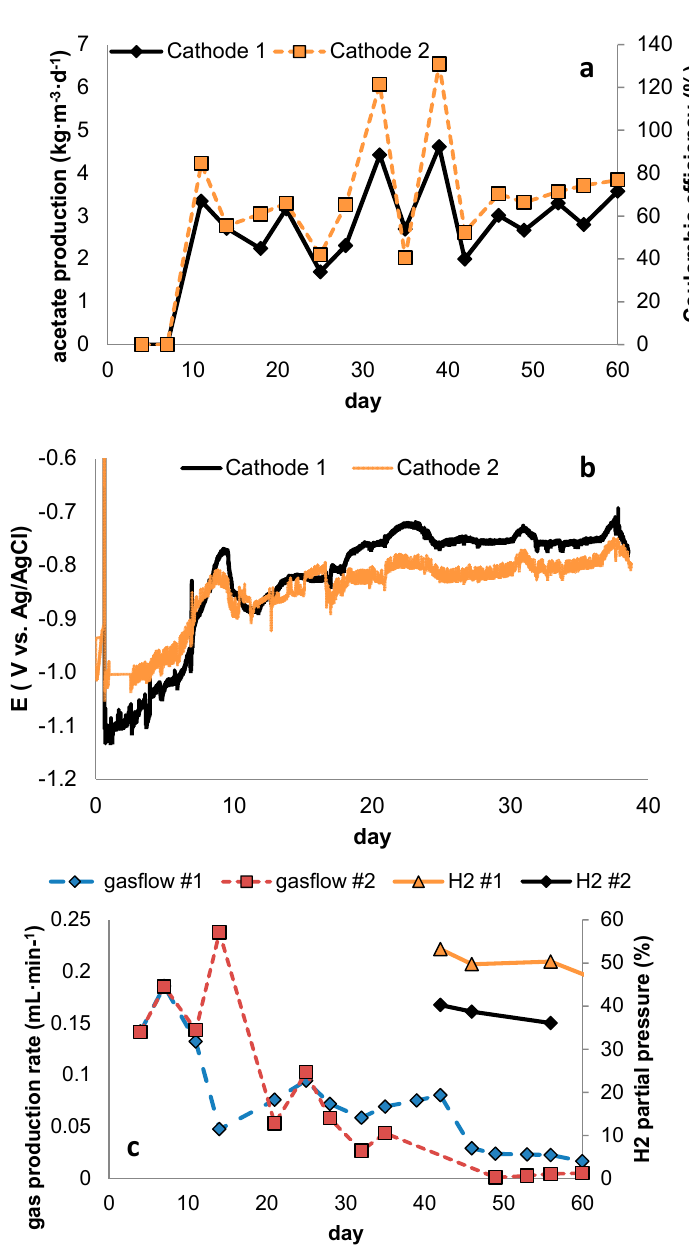
Figure 4. Results obtained in duplicate current controlled cathodes operated at 24 mA (11 A·m − 2 ) containing 10 mM of 2-bromoethanosulfonate (2-BES) in the electrolyte; ( a ) Acetate production steadily increased throughout the experimental run of 60 days, reaching nearly 4 kg·m − 3 ·day − 1 at a Coulombic efficiency of 80% at the end of the experiment; ( b ) The development of cathode potential over time displayed a steep increase at first, followed by a more stable operation around − 800 mV; ( c ) Starting at measurable fluxes, gas production gradually decreased for both cells—as an increasing share of current was directed towards production of acetate—and reached the detection limit by the end of the experiment.